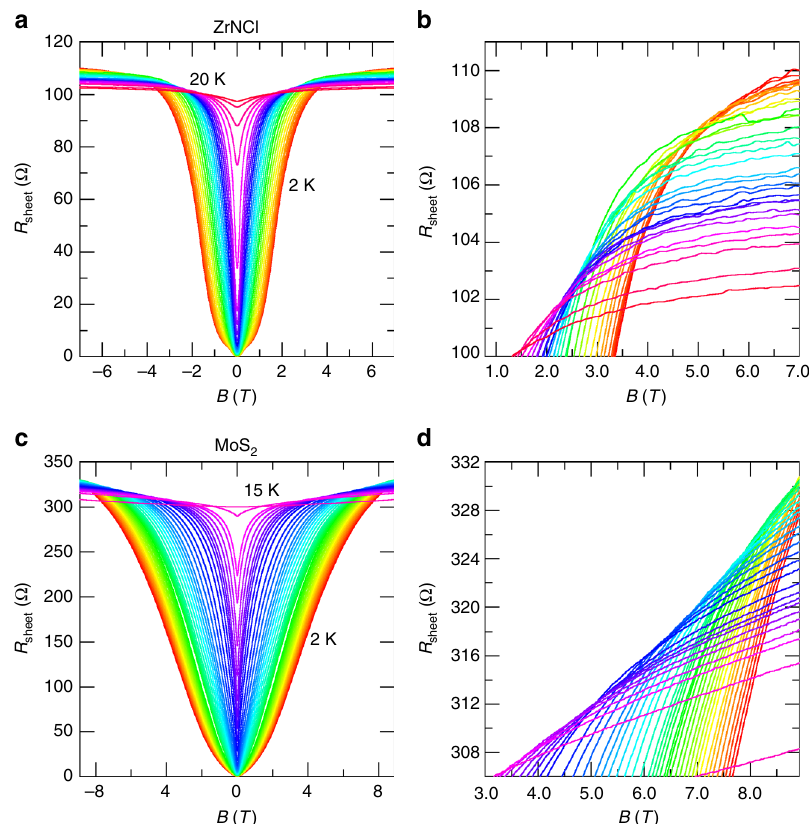
Fig. 2 Magnetoresistance and multiple critical points in a ZrNCl- and a MoS 2 -EDLT. a , c Sheet resistance as a function of out-of-plane magnetic fi eld at different temperatures in the ZrNCl-EDLT and the MoS 2 -EDLT. The measurement temperatures for the ZrNCl-EDLT range from 2 to 20 K (2, 2.3, 2.5, 2.7, 3, 3.3, 3.7 K, in 0.5 K steps from 4 to 13 K, in 1.0 K steps from 14 to 18 K, and 20 K). The measurement temperatures for the MoS 2 -EDLT range from 2 K to 15 K (in 0.1 K steps from 2 to 4 K, in 0.2 K steps from 4.2 to 5.4 K, 6, 6.3, 6.7, 7, 7.3, 7.5, 8, 8.3, 8.7, 9.1, 10, and 15 K). b , d A close-up view of around multiple crossing points of R – B curves for the ZrNCl-EDLT ( b ) and MoS 2 -EDLT ( d